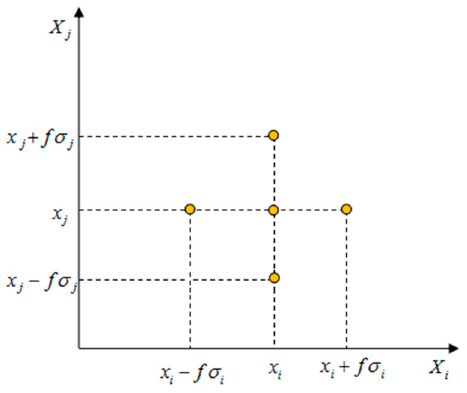
Figure 1. Bucher-star Design.